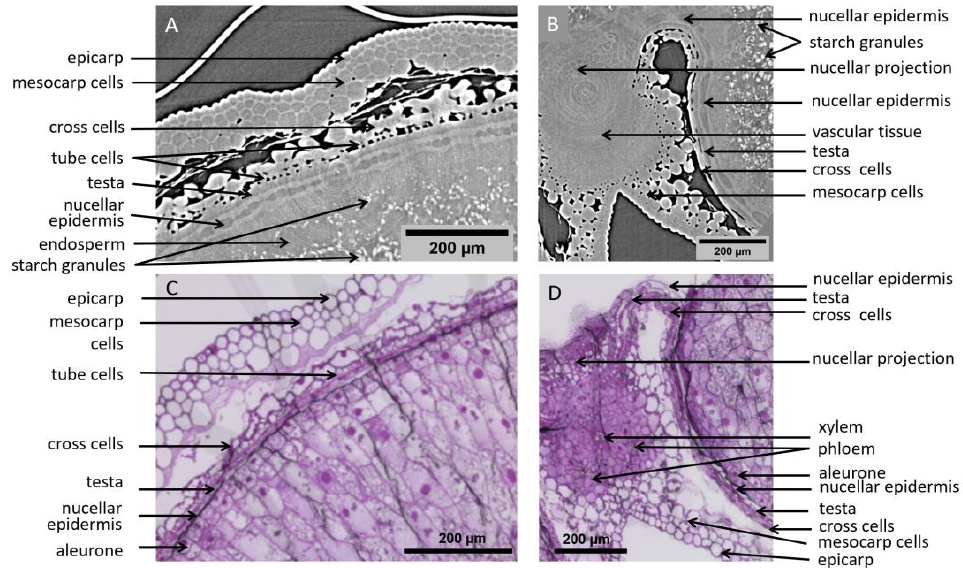
Figure 6. Highlighted region from high-resolution images of wheat grains at 250 °DAA. ( A ) Zoom on the dorsal region, revealing several cell layers. ( B ) Zoom on a region around the bundle. ( C , D ) Microscopy images (Toluidine Blue O stained) in similar regions as ( A , B ) respectively.